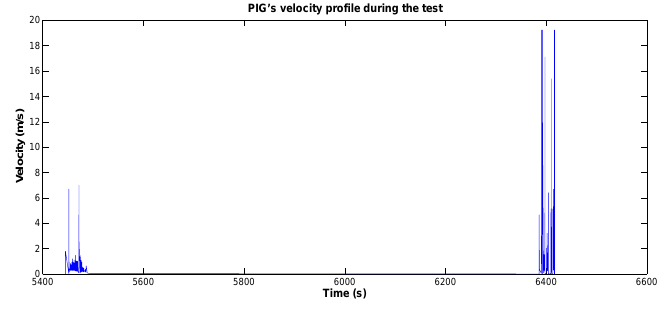
Figure 14. PIG’s velocity profile during the test. Source: By Authors.